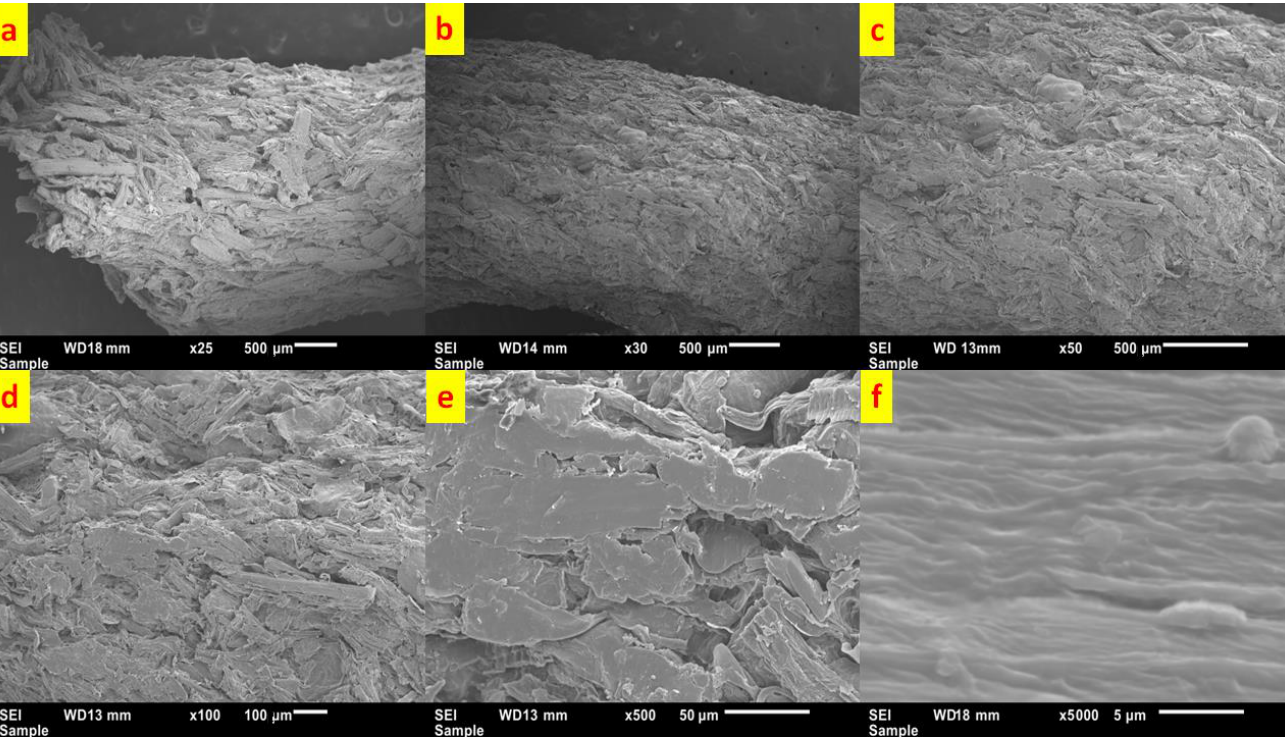
Figure 4 . SEM images of the prepared WS60 composite pellet with variable magnification: ( a ) 25×, ( b ) 30×, ( c ) 50×, ( d ) 100×, ( e ) 500× and ( f ) 5000×.